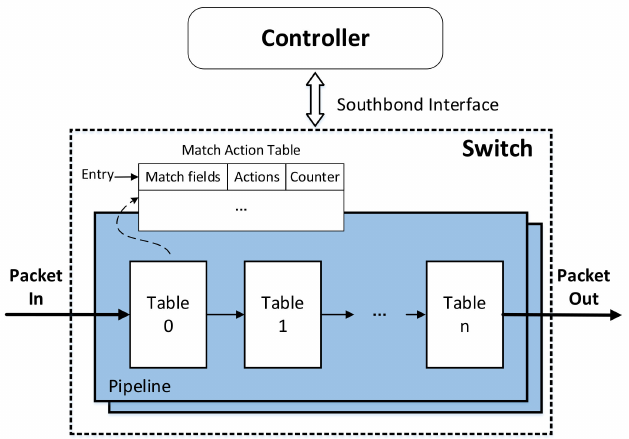
Figure 1. The pipeline uses match-action tables to process the